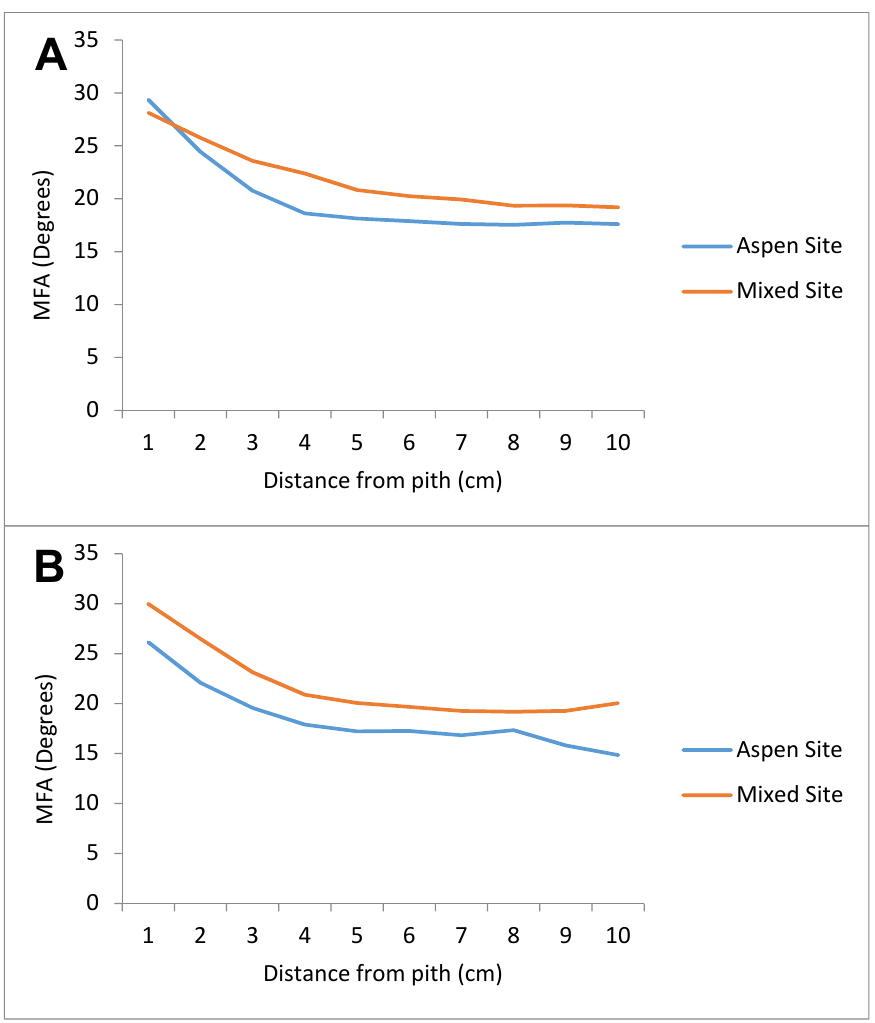
Figure 3. Mean microfibril angle (degrees) at given distances from pith for all dominant ( A ) and co-dominant ( B ) trembling aspen trees in aspen site (PSP 430) and mixed site (PSP 434). n = 100 for the aspen site, while n = 50 for the mixed